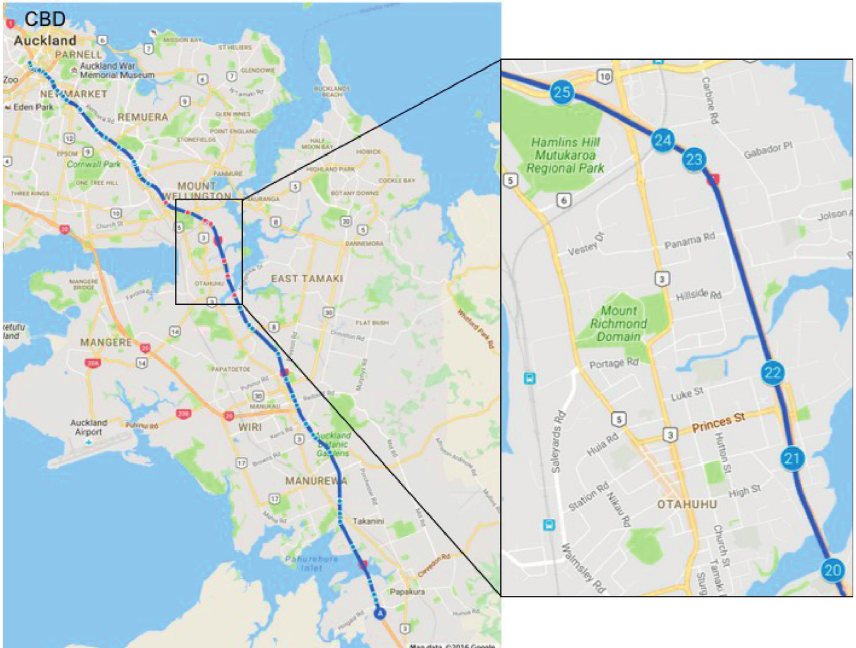
Figure 1: Study area with 45 road segments spread over 30km of State Highway 1 (SH1) in Auckland. Volume and occupancy values from these road segments over a period of 30 days were used in this